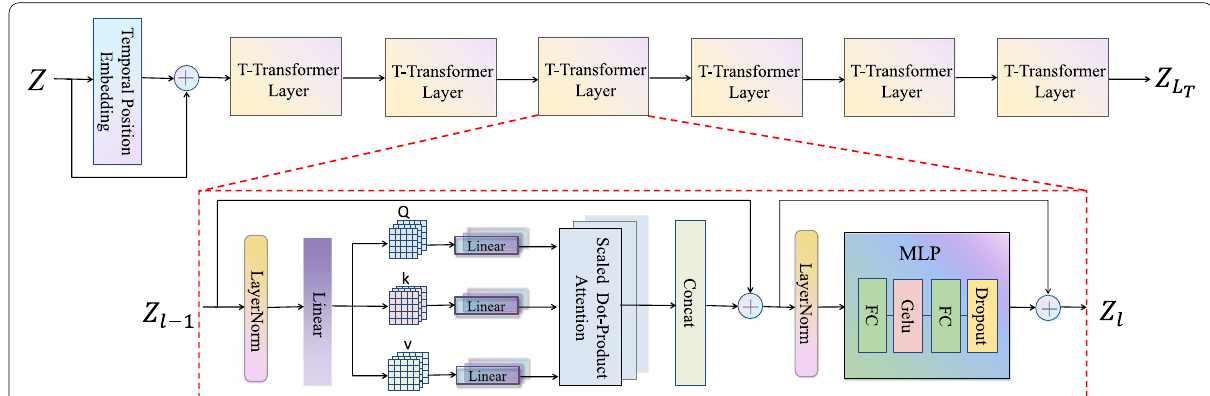
Fig. 2 Temporal transformer (T-transformer) module. The module combines the encoded features of the connected human pose vector Z through the TPE and the input sequence, and obtains the output Z L T through the T-transformer module composed of 6 identical T-transformer layers. Specifically, each T-transformer layer will through the layer norm, and then the multi-head attention calculation is performed by the dot product attention composed of Q, K, and V of multiple heads, and finally connect the attention results and pass through the MLP composed of two FC